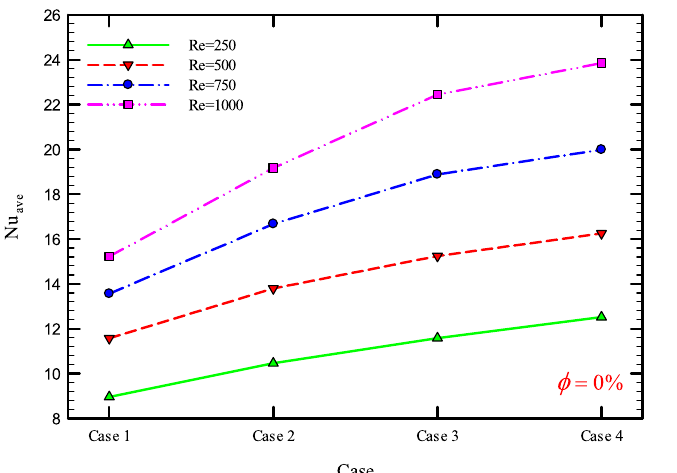
Figure 29. Nu ave for different cases for φ = 0% .